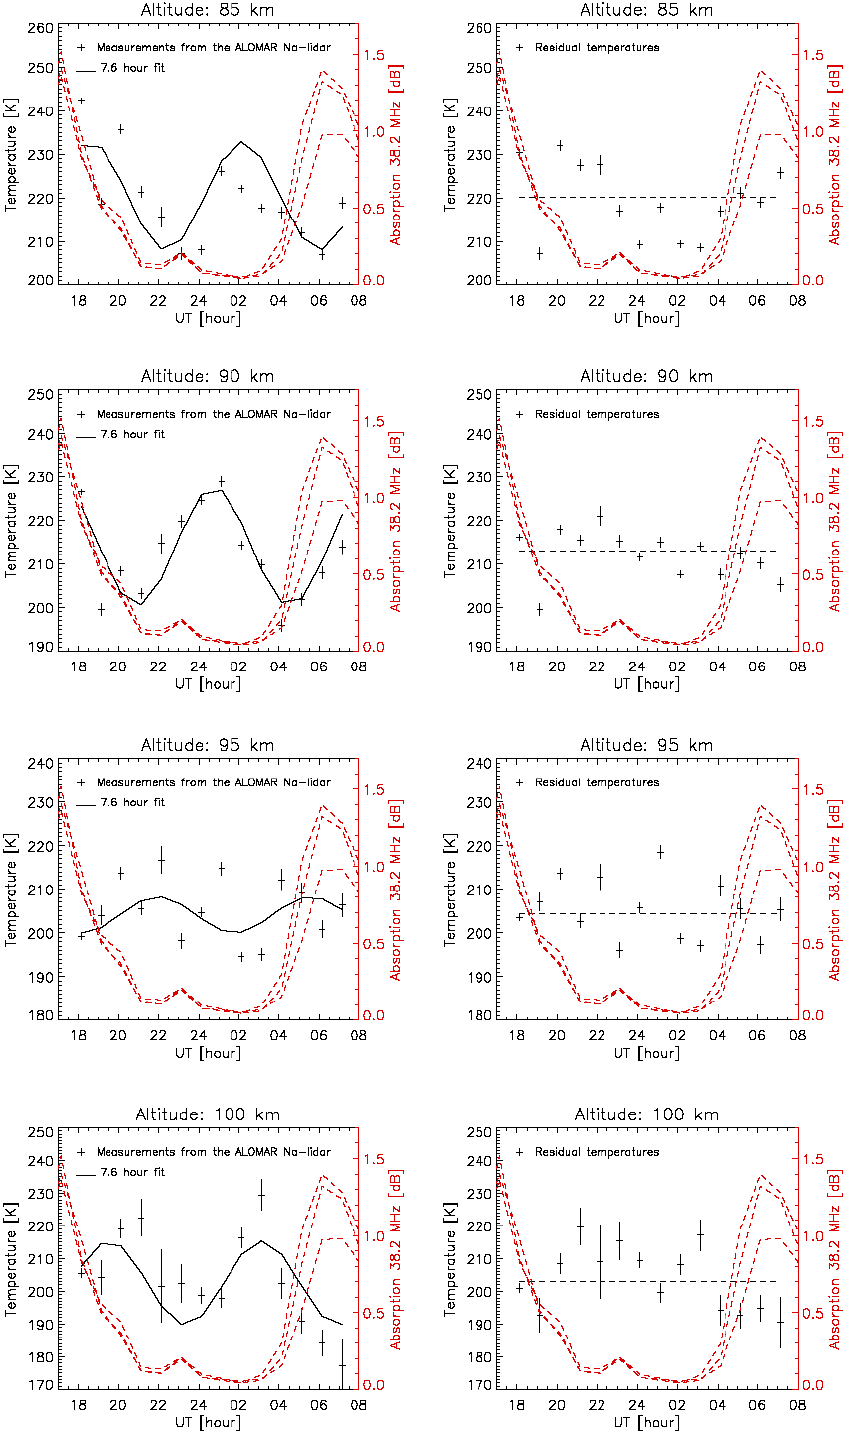
Fig. 10. The left column shows the hourly averaged temperatures, marked as crosses, from beam 1 the ALOMAR Weber Na lidar on 21–22 January 2005 at 4 different heights. The solid black line shows a 7.6-h wave fit to the temperatures. The right column shows the temperature residuals when subtracting the wave fit. The red dashed lines show the cosmic radio noise absorption measured by IRIS in beam 8, 15 and